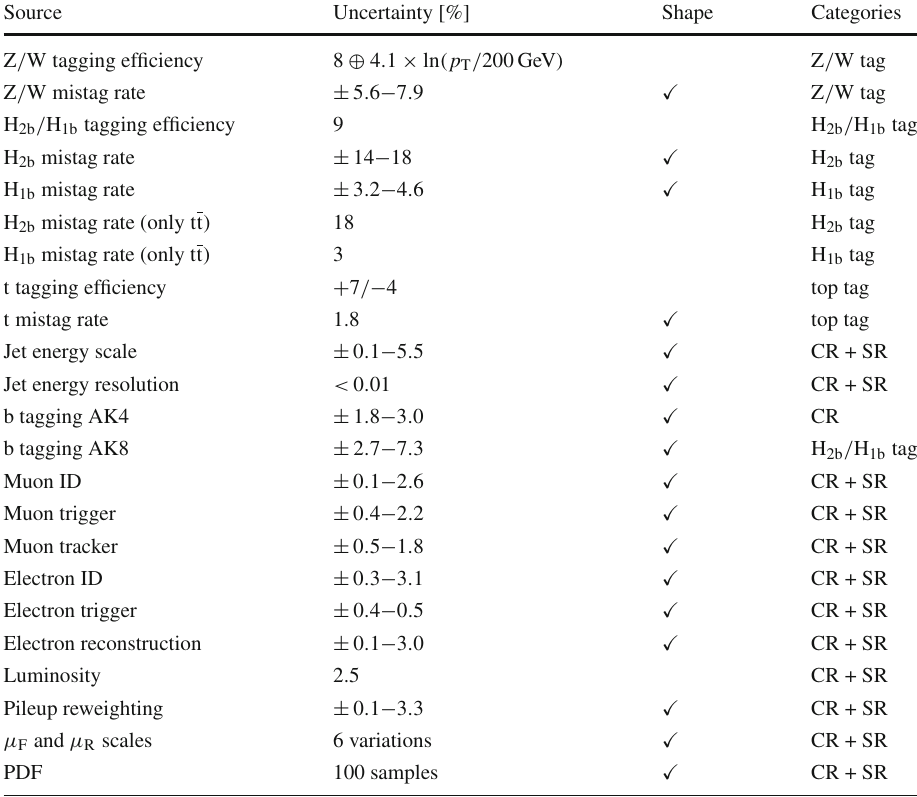
uncertainties considered in the statistical analysis, with the size of their impact, the type(s) of effect they have, and the categories they affect. The impact size of each uncertainty is based on a signal sample with